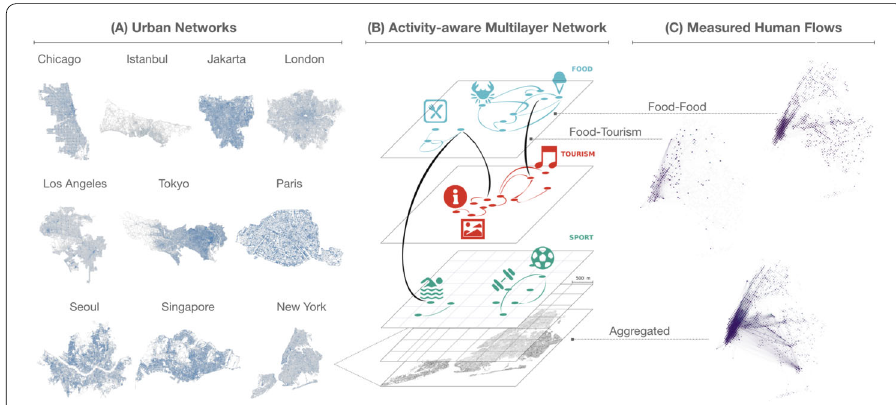
Figure 1 Modelling Structure and Function of Urban Systems. Left: Urban structural backbone of the 10 megacities considered here, as described from their street networks (data obtained from Open Street Map [68]). Middle: Urban functional networks described by the Foursquare data. The nodes are obtained by dividing the area analysed into cells of 500 m × 500 m. The edges are subsequent check-ins that might be between activities of the same type (intra-links: e.g. Food-Food, Tourism-Tourism) or different types (inter-links: e.g. Food-Tourism, Food-Sport). The collection of layers and inter-layer flows defines a multilayer network [4, 6, 7], i.e., a multidimensional functional representation of the urban areas. Right: The mobility flows between areas are captured as the edges’ weights. In the example, describing New York City, we can observe